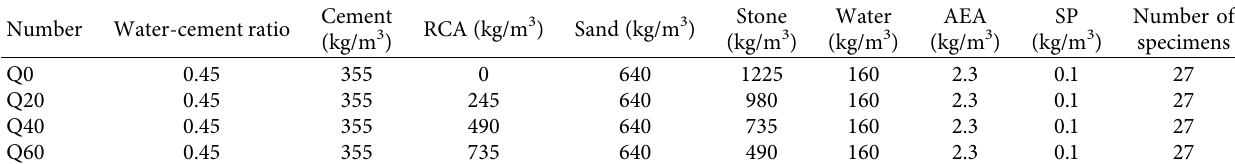
Table 4: Mix ratio of recycled